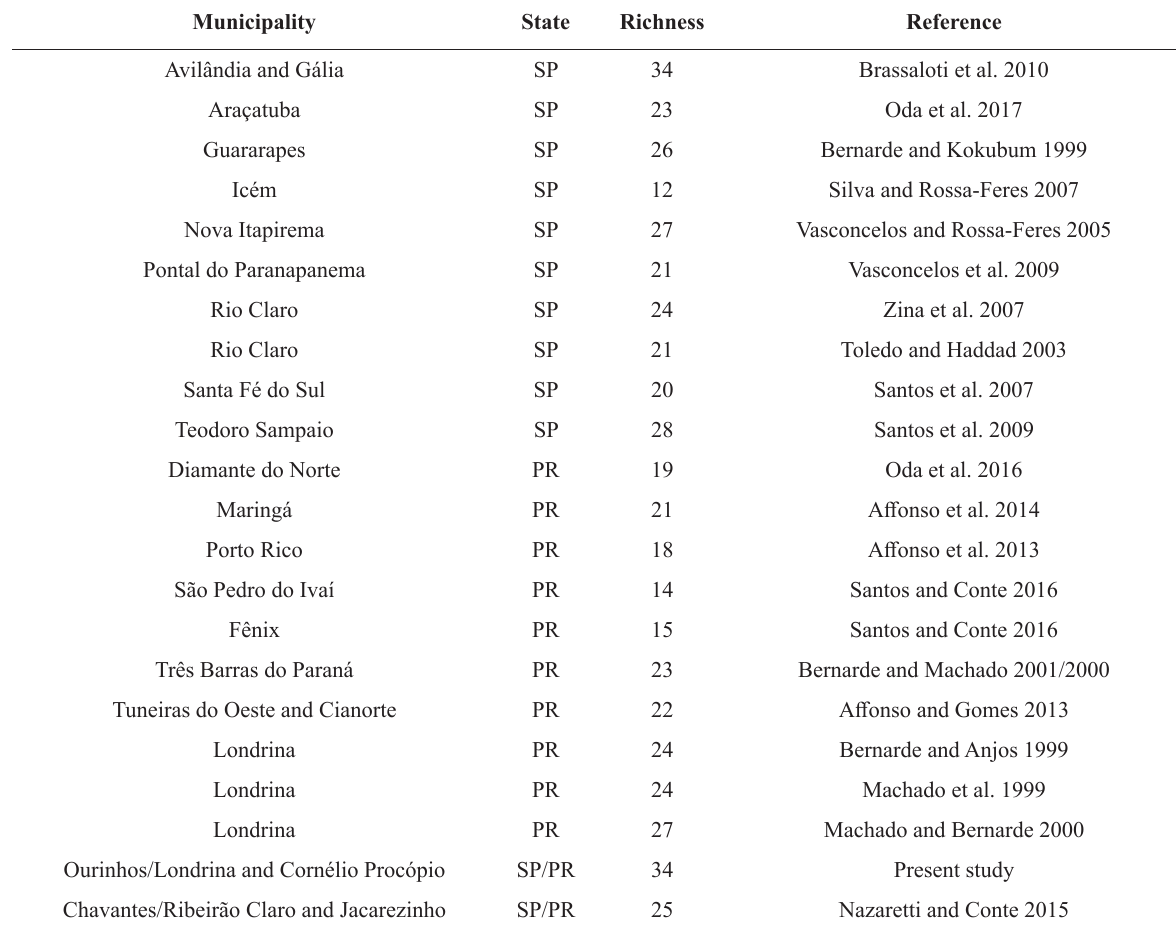
List of municipalities that had the anurofauna studied in the Mesophytic semideciduous forest in the states of São Paulo (SP) and Paraná (PR) considered in this